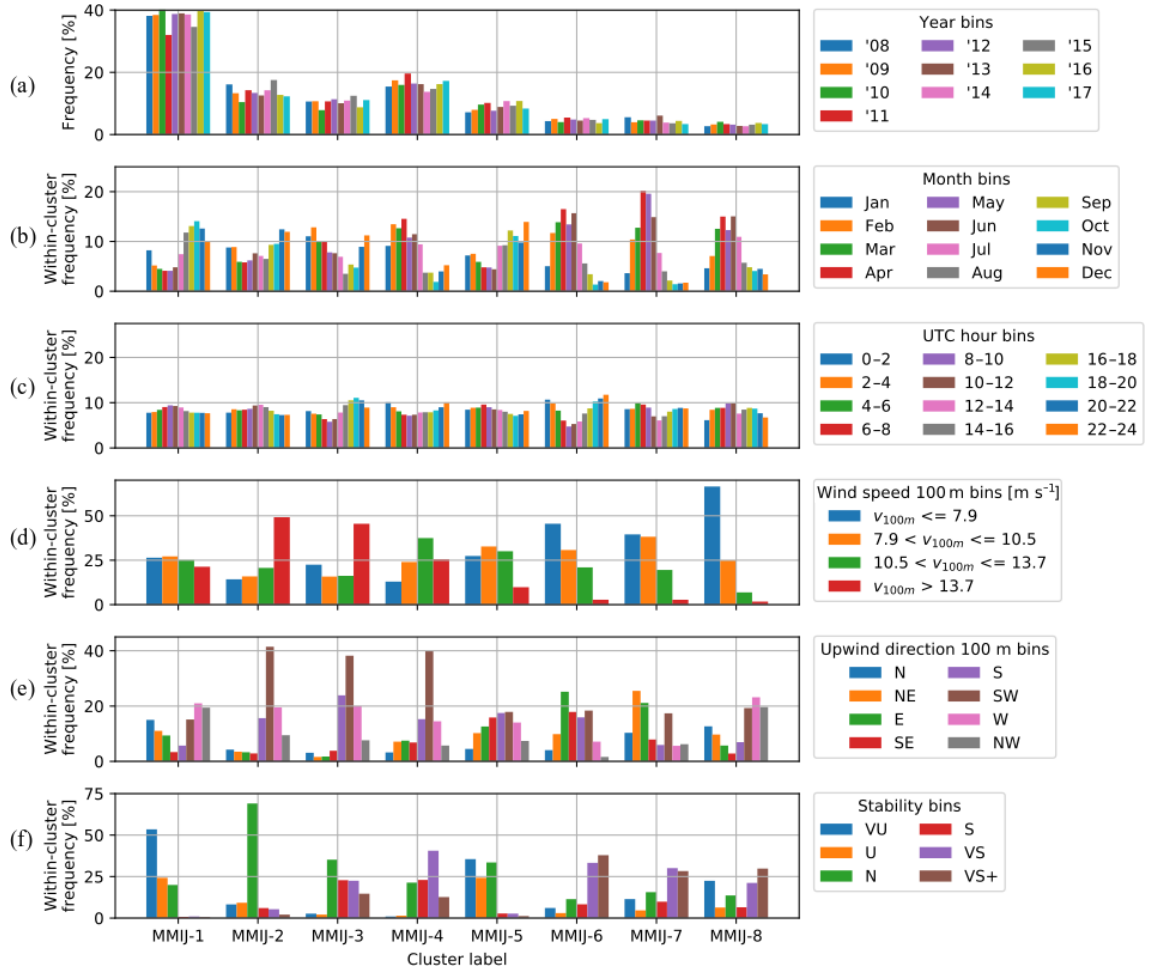
Figure 10. Frequency distributions broken down into bins by time of occurrence (a, b, c) , wind speed and direction at 100m (d, e) , and atmospheric stability (f) for the filtered offshore dataset. The wind speed bin limits are chosen such that the frequency over all clusters for each bin is roughly the same. The stability bins correspond to the classes in Table 1 together with the VS+ bin ( Ri B ≥ 0 . 2). The other distributions have equal bin